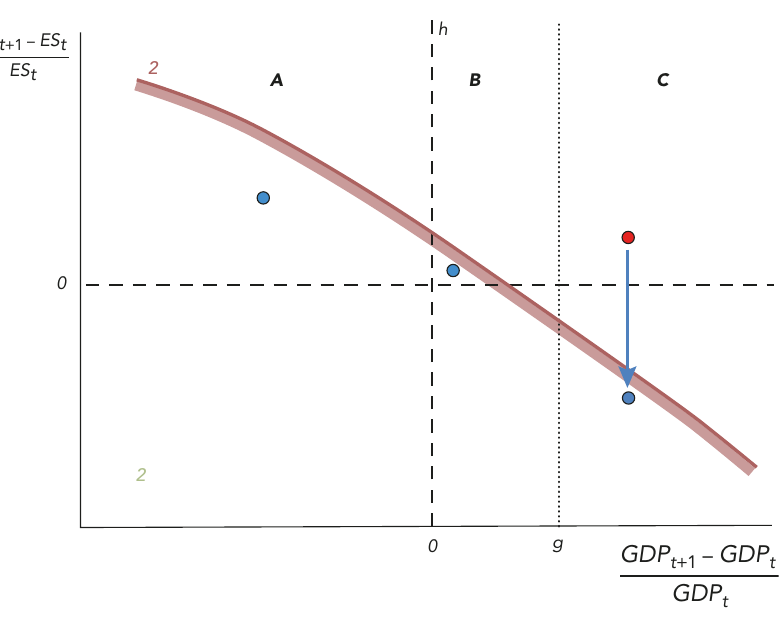
Figure 2. Growth strategy fails in case of conflict between growth and environmental sustainability, while degrowth and agrowth strategies remain within feasibility area indicated by area below brown curve